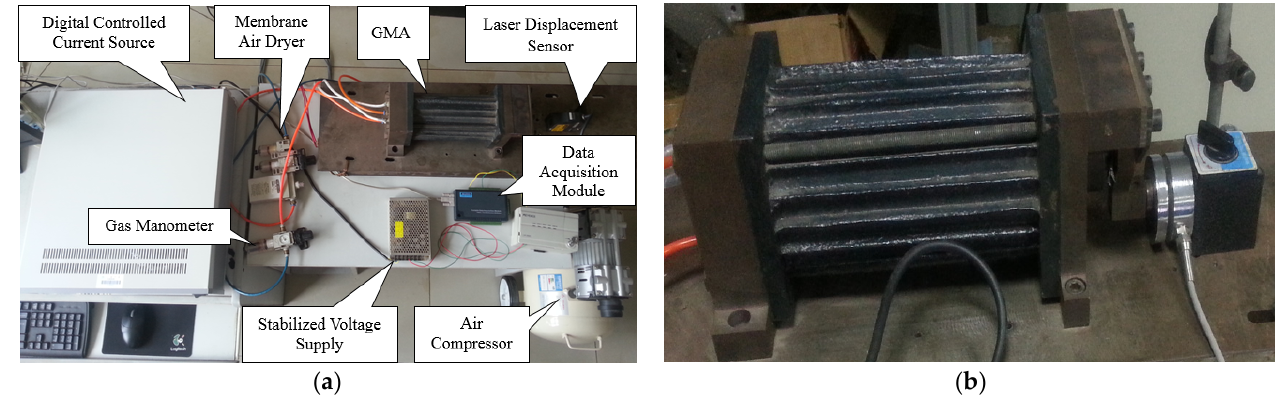
Figure 4. The experimental test system: ( a ) System connection diagram; ( b ) GMA actuator.